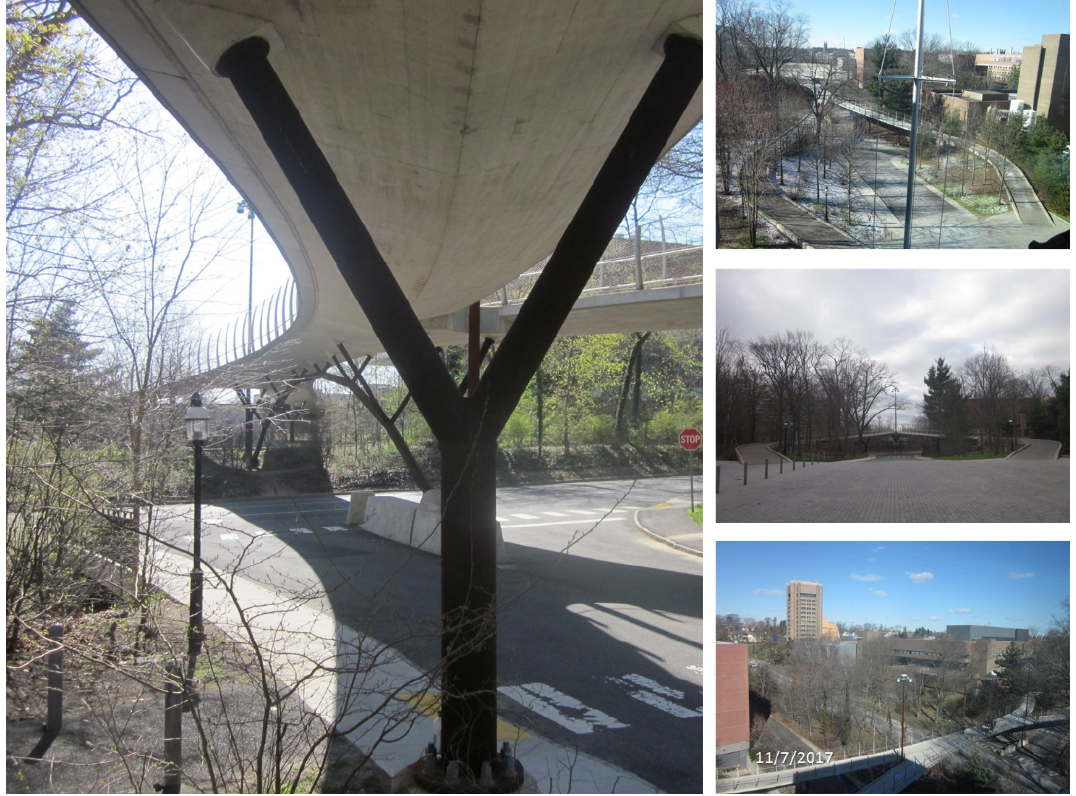
Figure 4. Photographs illustrating complex 3D geometry of Streicker Bridge